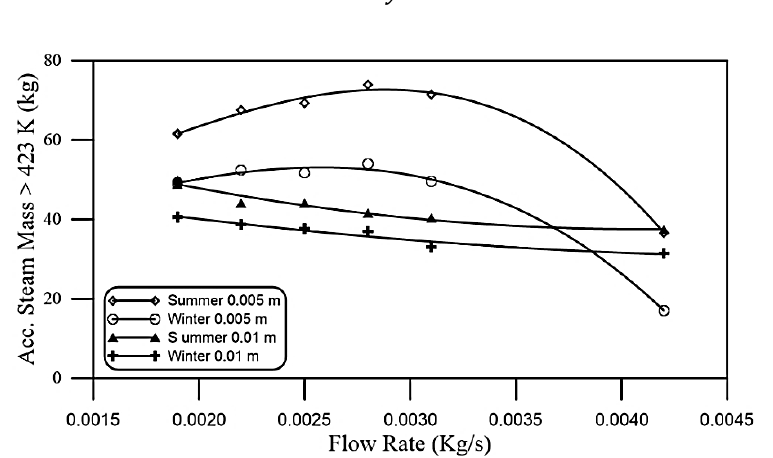
Figure 15. Accumulated steam whose temperature is over 423 K for 0.005 m and 0.01 m tubes in winter and summer, respectively.